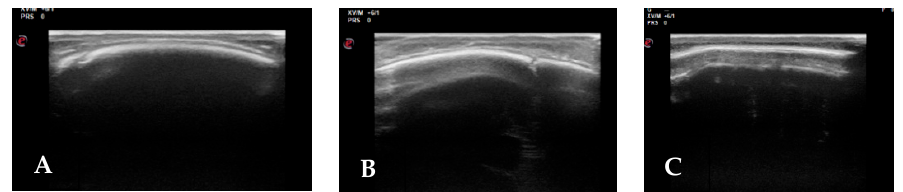
Figure 1. Suture US: ( A ) Patent right coronal; ( B ) Patent right lambdoid; ( C ) Synostotic sagital.